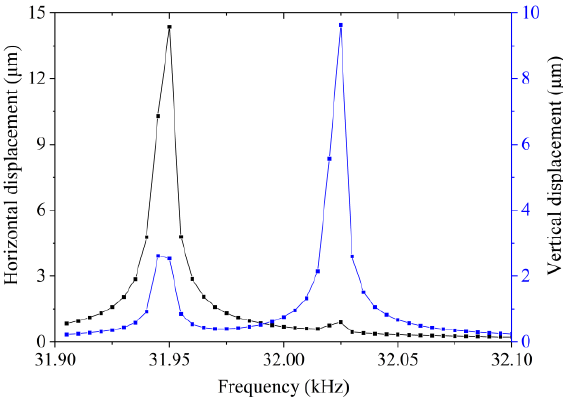
Figure 5. Vibration displacements of the observation spot under variant frequencies.